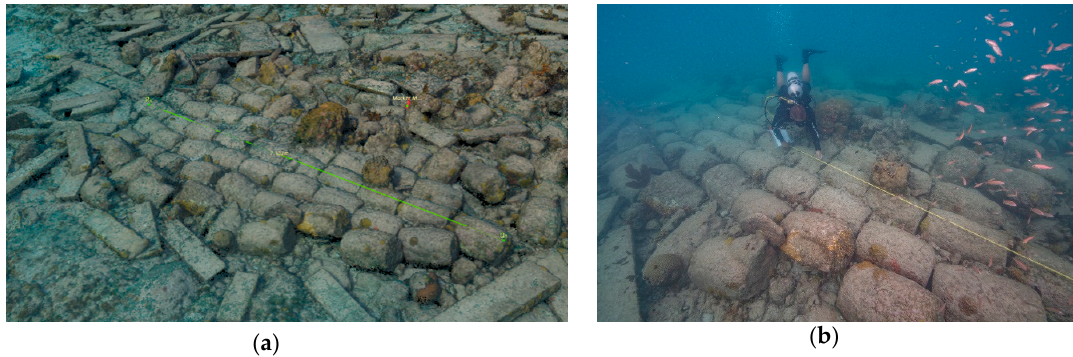
Figure 10. Line of barrels measured as depicted in Viscore ( a ) and as measured by hand ( b ).